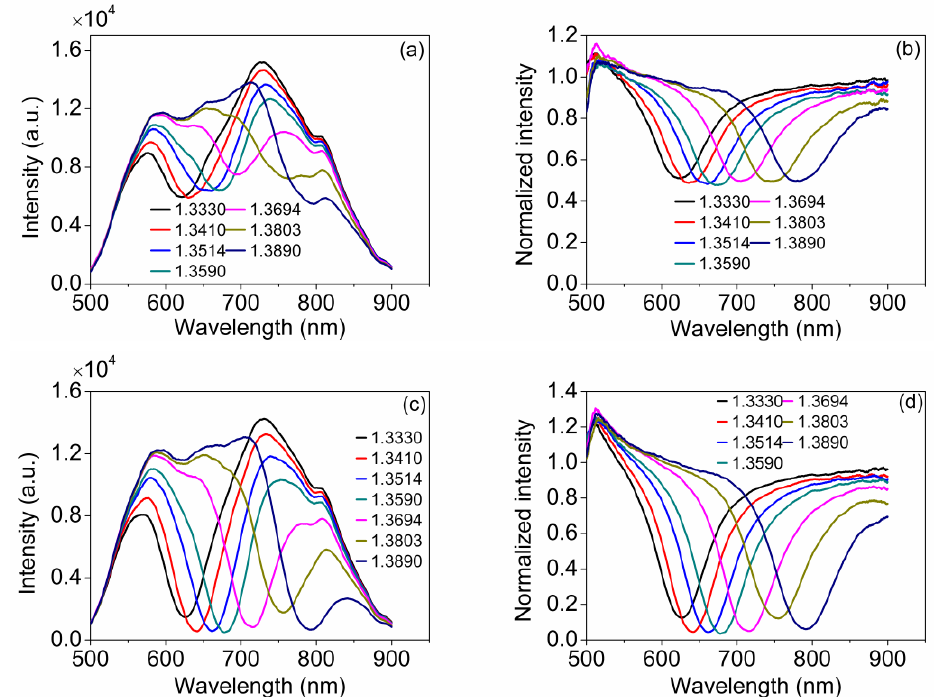
Figure 4. ( a ) Testing results of the spectrum reflected back off the sensor when only the second sensing region is immersed into glycerine aqueous solutions; ( b ) Corresponding normalized SPR spectrums; ( c ) Testing results when the whole bi-prism is immersed into glycerine aqueous solutions; and ( d ) Corresponding normalized SPR spectrums.